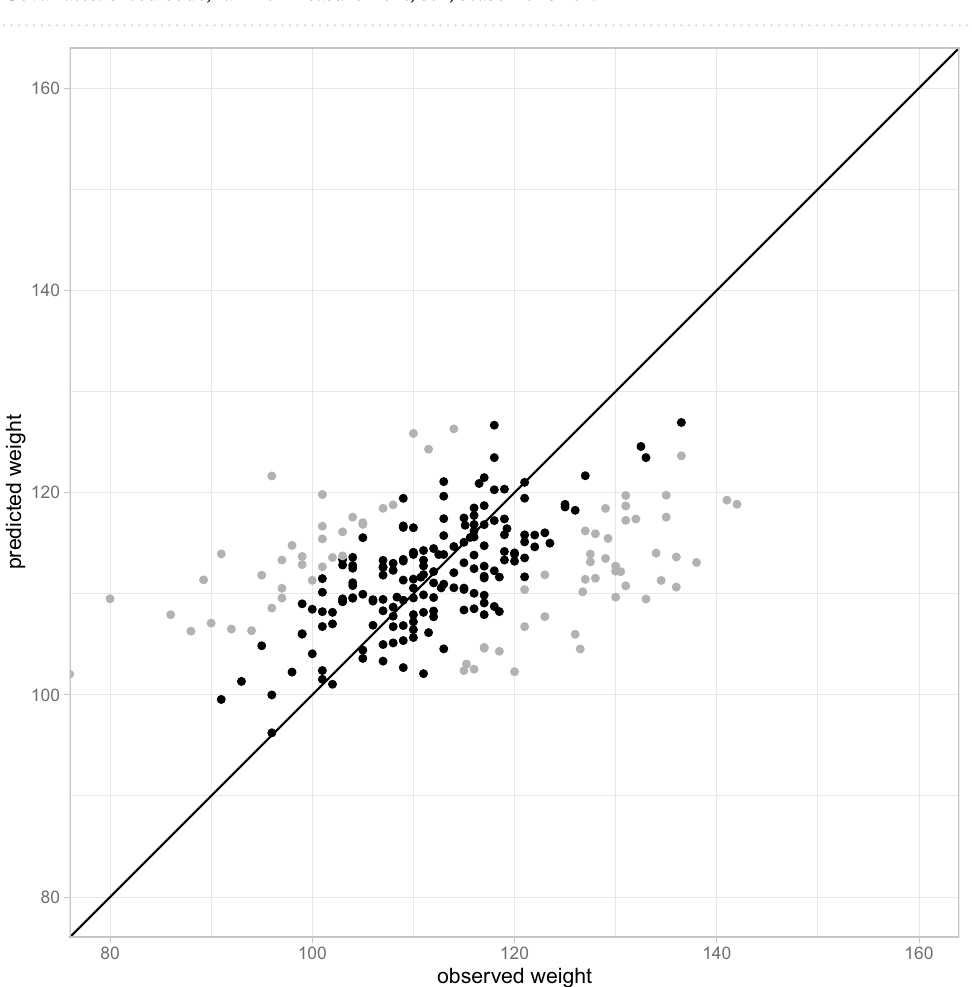
Table 3. Results of prediction models for weight gain with decreasing amount of measurement history used. Covariates: breed code, farm of measurement, sex, season of birth.